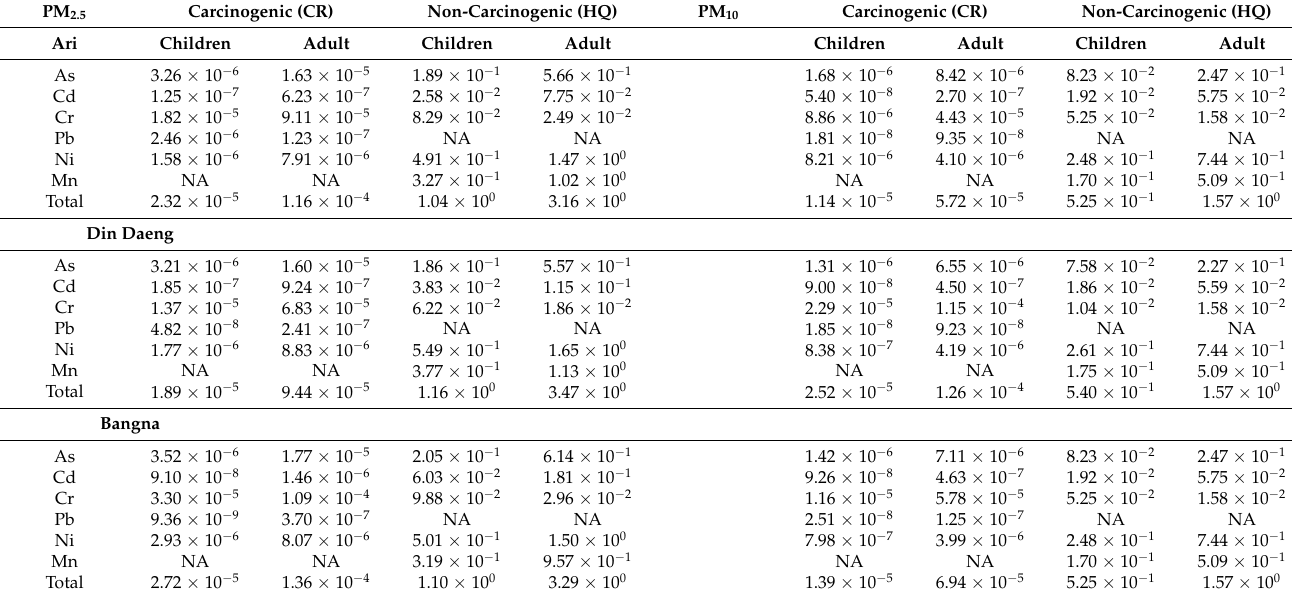
Table 3. Carcinogenic and non-carcinogenic risk of heavy metals via inhalation exposure of PM 2.5 and PM 10 at Ari, Din Daeng, and Bangna, Bangkok,